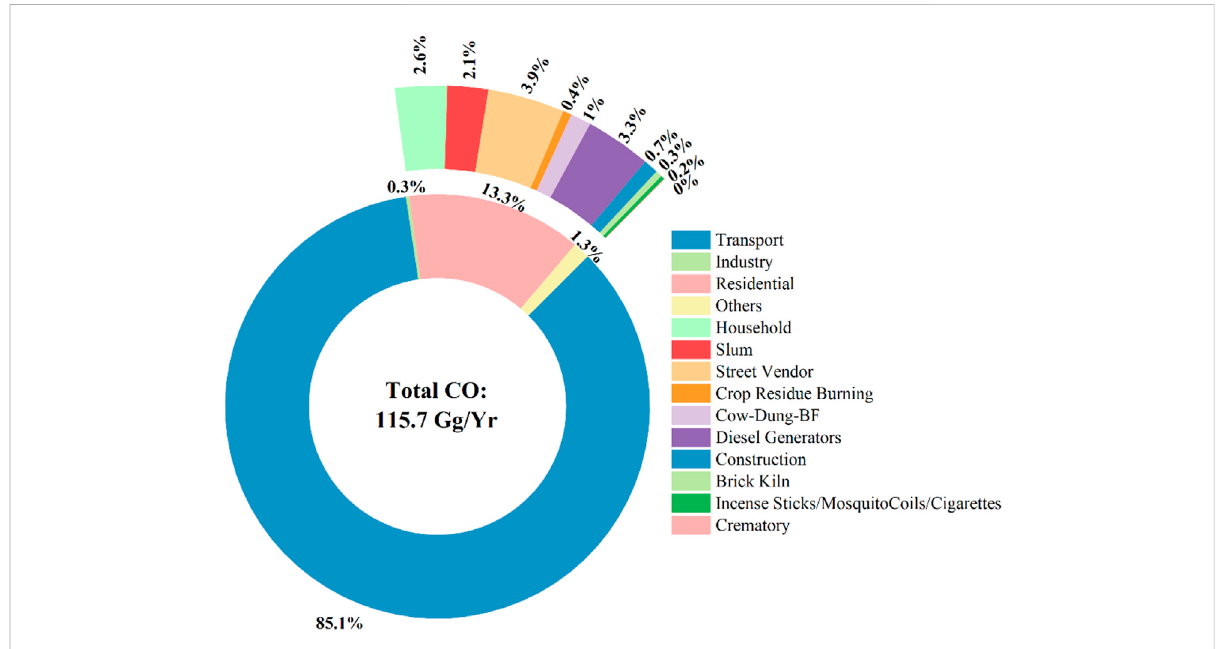
FIGURE 9 Contribution of CO from major and minor